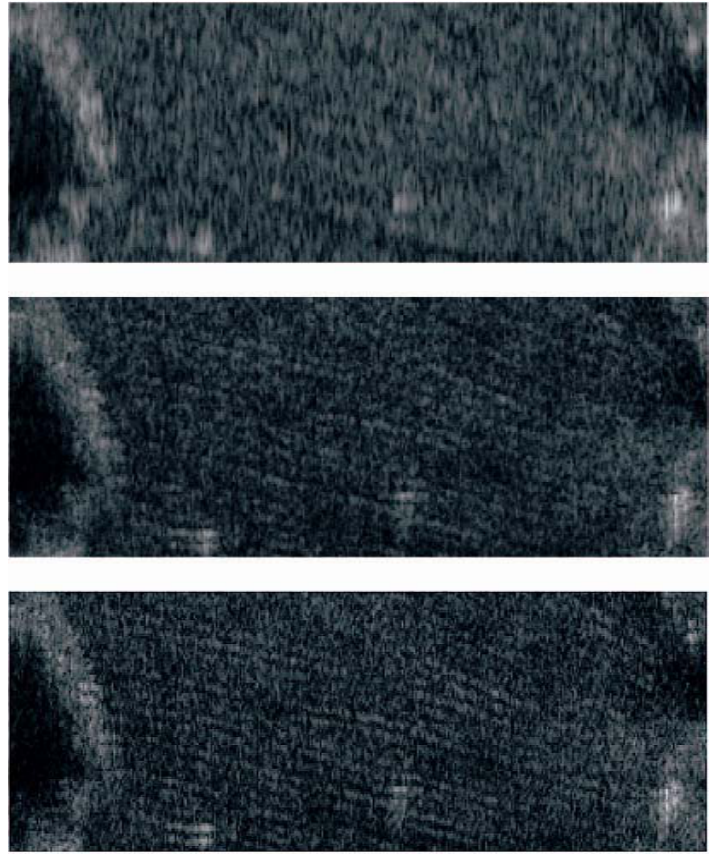
Figure 6. An expanded image of region A. Single chirp 200 MHz (top), SWW (600 MHz) with conventional algorithm (center), SWW (600 MHz) with proposed algorithm (bottom). The size of each imaged area is 70 m x 20 m.